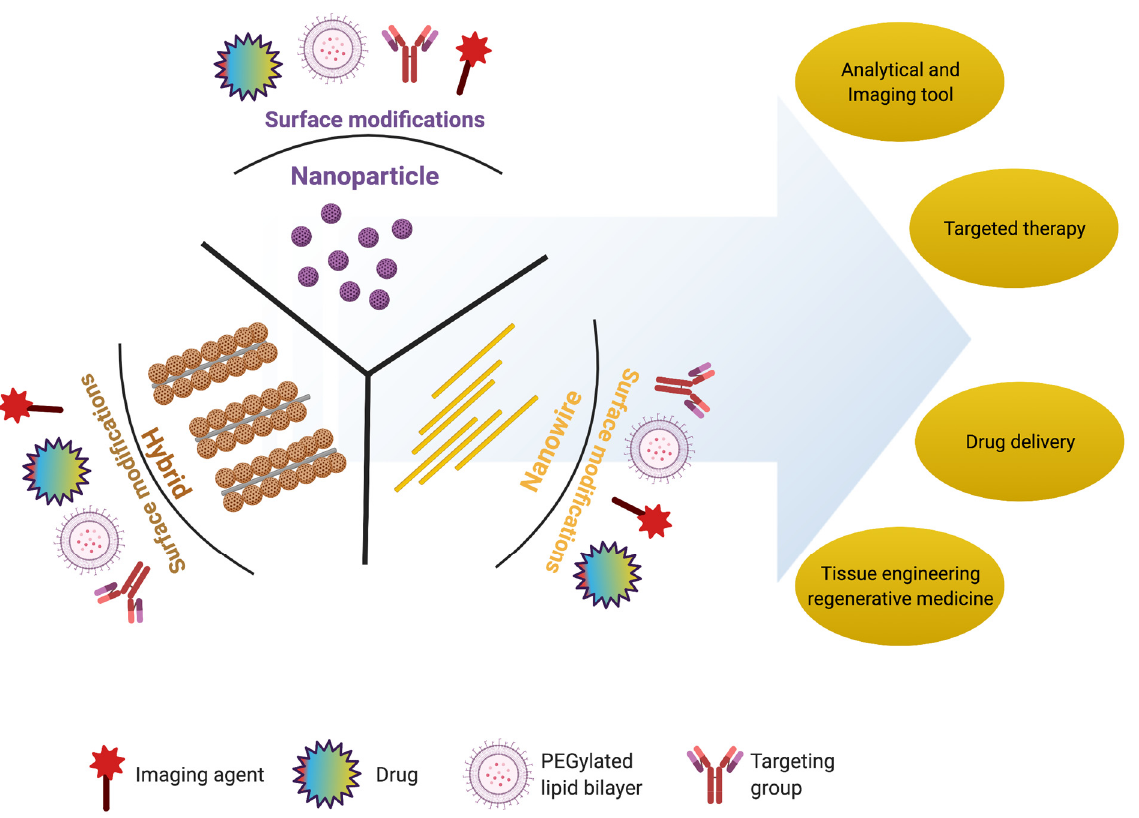
Figure 2. Schematic representation of multifunctional nanostructures: nanoparticle (NP), nanowire (NW), and hybrid with various applications in biomedical science. These nanostructures can be surface modified with drugs (incorporated or conjugated to the surface), a PEGylated lipid bilayer (to improve solubility and decrease immunogenicity), targeting groups (to improve nanostructures’ circulation, effectiveness, and selectivity), and imaging agents (e.g., fluorescent dyes used as reporter molecules and employed as tracking or contrast agents).